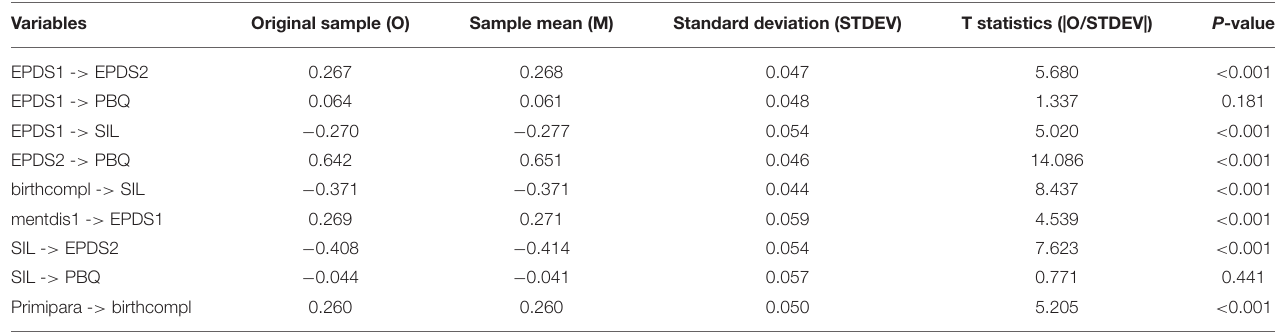
TABLE 4 | Structural model with imputed missing data ( n =